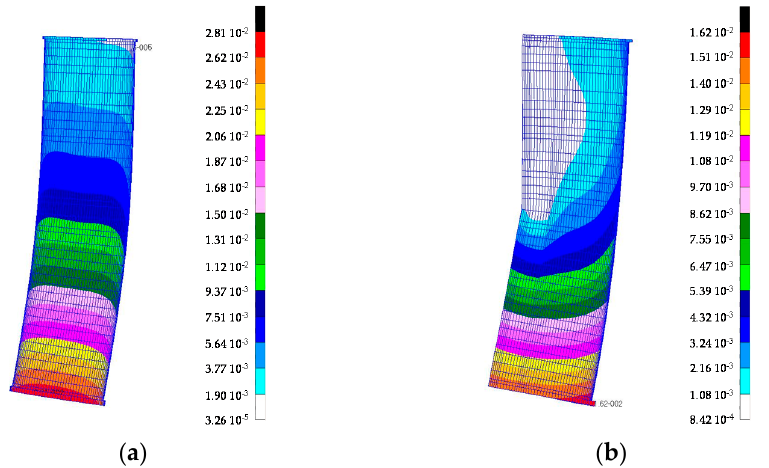
Table 3. The structure mass comparison.